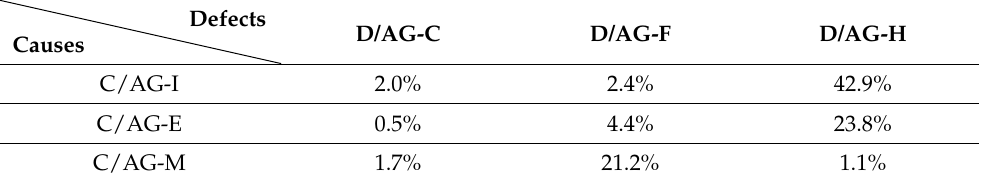
Figure 7. Number of cases by affinity groups.